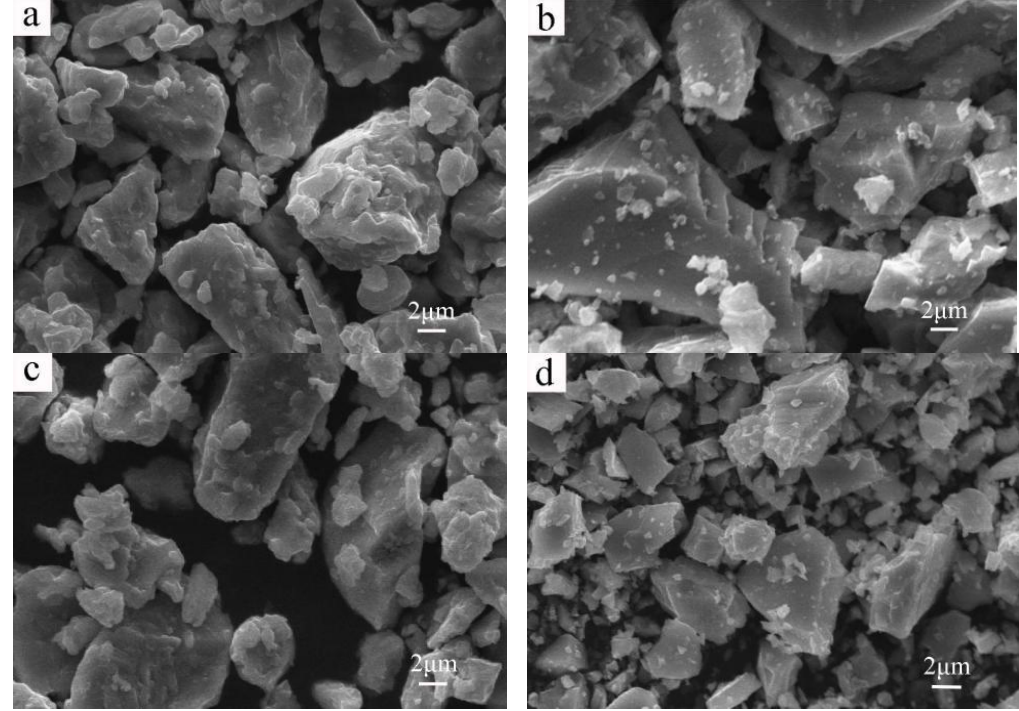
Figure 1. Micrograph of composite powders: ( a ) Ti-7Al-0.2B ball milling 5 h; ( b ) TiH 2 -7Al-0.2B ball milling 5 h; ( c ) Ti-7Al-0.2B ball milling 40 h; ( d ) TiH 2 -7Al-0.2B ball milling 40 h.